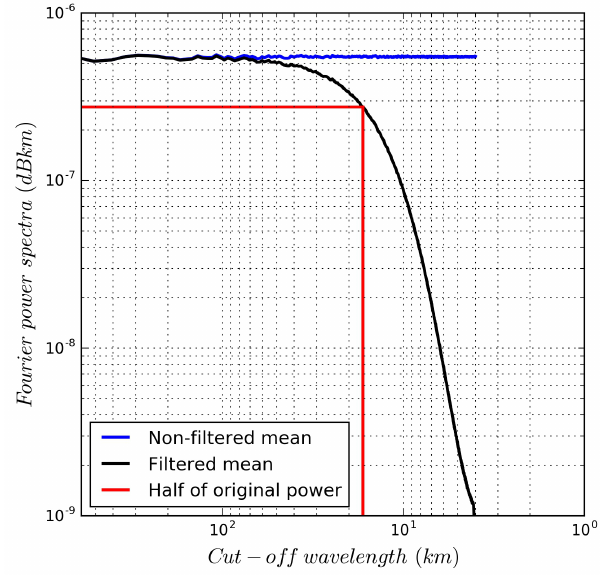
Figure A1. Illustration of how the parameterization corresponding to a 15 (16.72) km cut-off wavelength ( λ c ) is estimated. The blue line represents the mean spectra of the 100 non-filtered white noise fields. The black line is the mean spectra of the 100 filtered white noise fields. The horizontal red line shows the half-power spectra of the blue line, and the vertical red line the corresponding wavelength value of the black line, and thus the cut-off